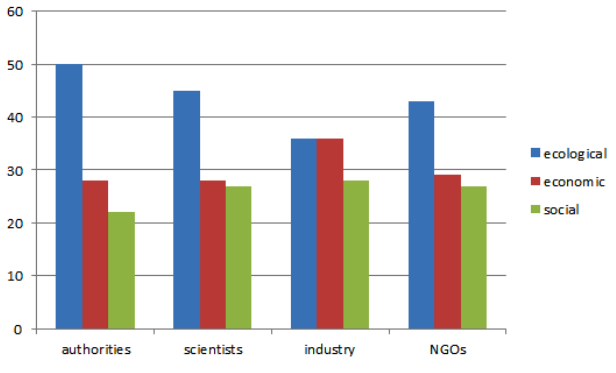
Fig. 6 . Average scores on the pillars for the stakeholder groups.